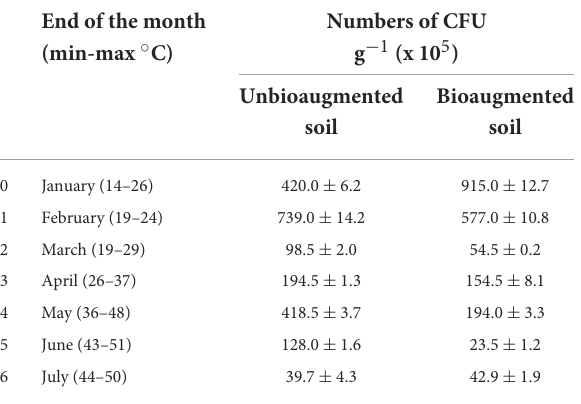
TABLE 1 Numbers of CFU of hydrocarbonoclastic bacteria in unbioaugmented and bioaugmented oil-polluted desert